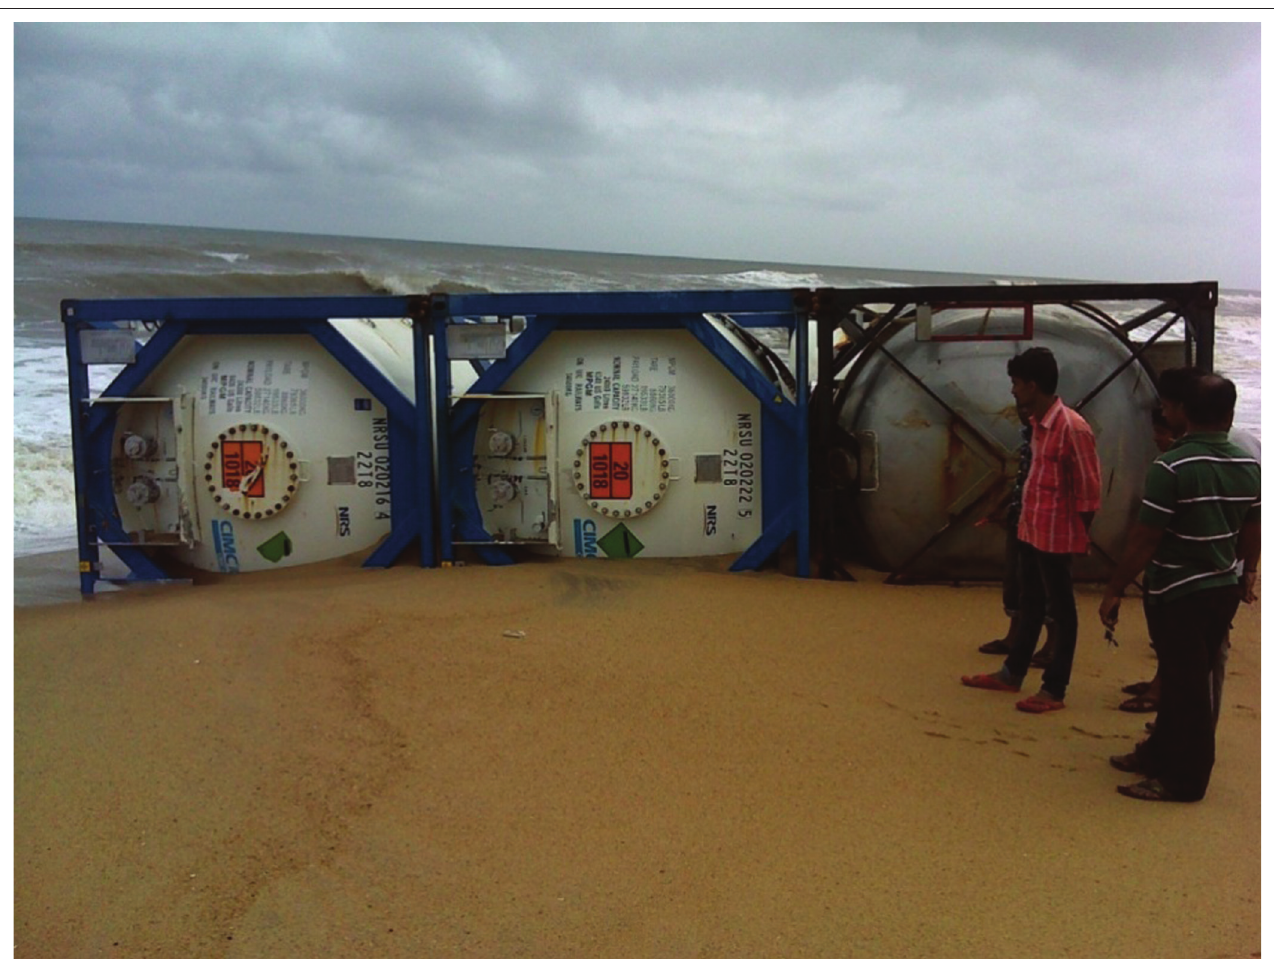
FIGURE 6: Three containers found together at Berikka